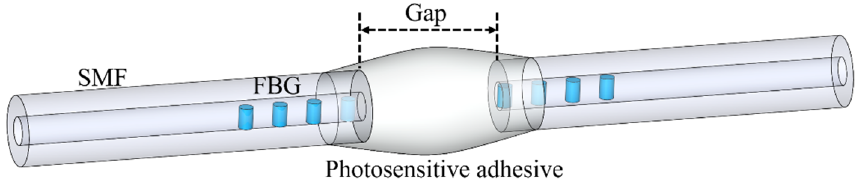
Figure 8. The schematic diagram of the photosensitive adhesive-infiltrated PS-FBG. The closed Fabry–P é rot interferometer can measure the changes in temperature, pres- sure and RI caused by the change of cavity length, while the wavelength of the phase shift peak of PS-FBG is only sensitive to temperature and the intensity of the structural phase shift spectrum is only insensitive to pressure. Due to the difference in sensing characteristics between EFPI and PS-FBG, the device can realize the differential measurement of tem- perature, pressure and RI by using the methods of wavelength modulation and intensity modulation. The sensitivity obtained from the experiment is shown in Equation (11). This integrated sensor has high research value in the field of multi parameter measurement.